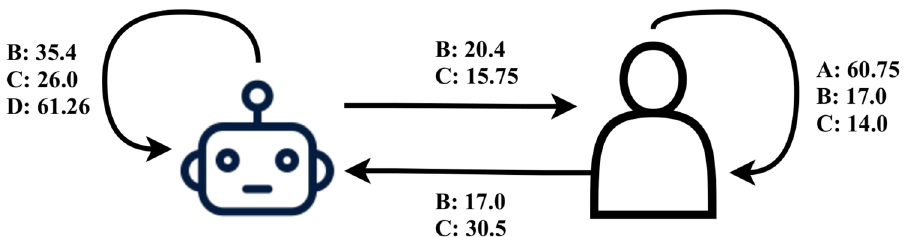
Figure 3. Average number of interactions between agent and human players of different colour for a game in the experimental setups. The varying agent concentrations in the colour groups resulted in different numbers of interactions between humans and agents. The numbers represent all the initiated interactions (i.e. requests sent). The number of initiated interactions in the purely human setup A and the purely agent based setup D are of the same range. However, the different group compositions in setups B and C have an effect on the number of initiated interactions in terms of human to agent and agent to human. It should be noted that the performance